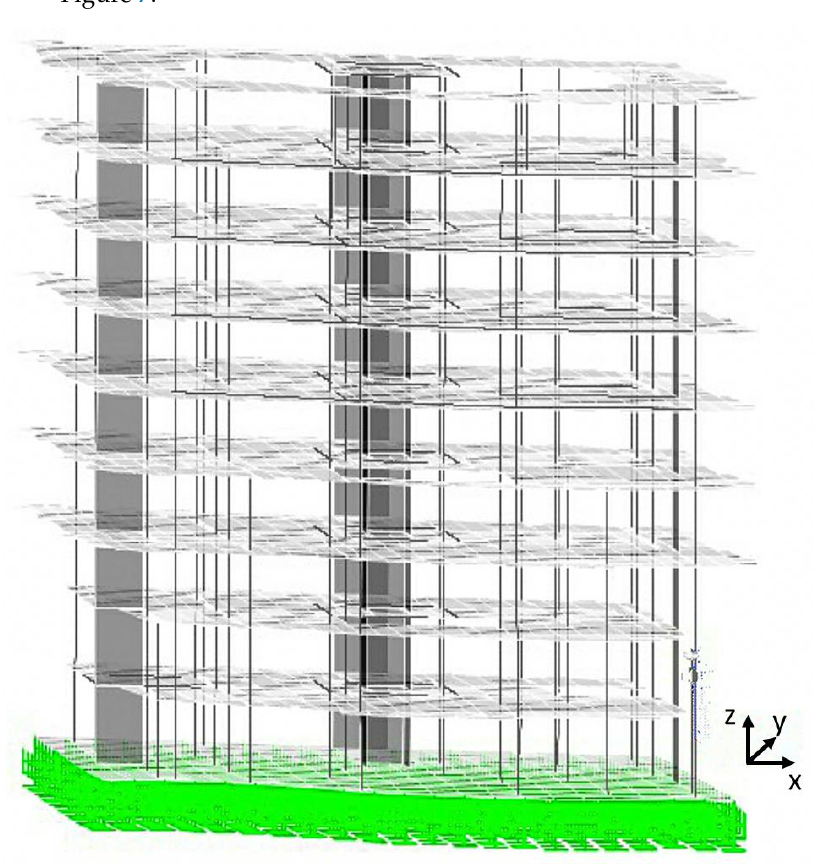
Figure 7. 3D finite element model of the tilted building developed by using ETABS.